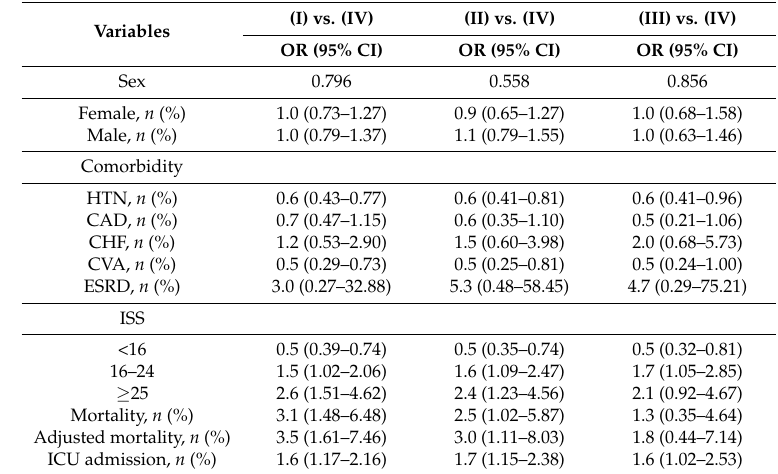
Table 3. Comparison between SIH in diabetes based on defined glucose levels against the patients with diabetic